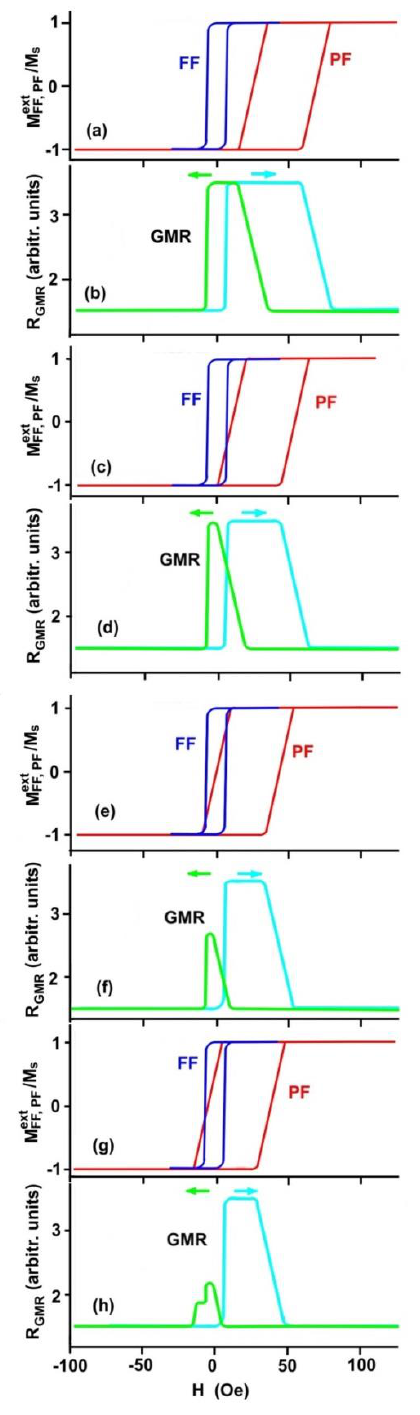
Fig.2 Hysteresis loops (blue – free F, red – pinned F) and corresponding calculated MR curves (light blue for increasing external magnetic field, light-green – for decreasing). Exchange bias decreases from (a) to